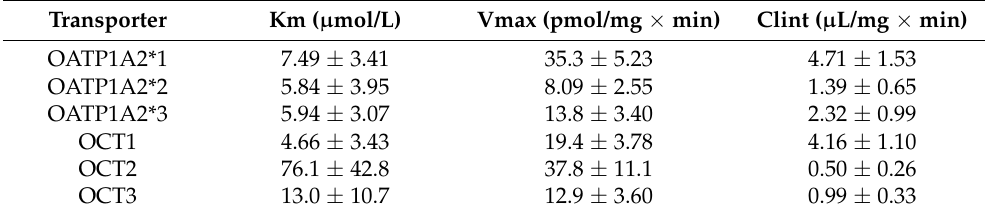
Figure 2. ( A ) Uptake of doxorubicin into stably transfected HEK293 cells expressing OATP1A2*1, *2, *3, and ( B ) into MDCKII cells stably expressing OCT1, 2 and 3 (data given as mean ± SD; n = 3). Table 1. Kinetic data for the doxorubicin uptake in stable transfected HEK293 cells expressing OATP1A2*1, *2 or *3 and MDCKII cells expressing OCT1, OCT2, or OCT3.